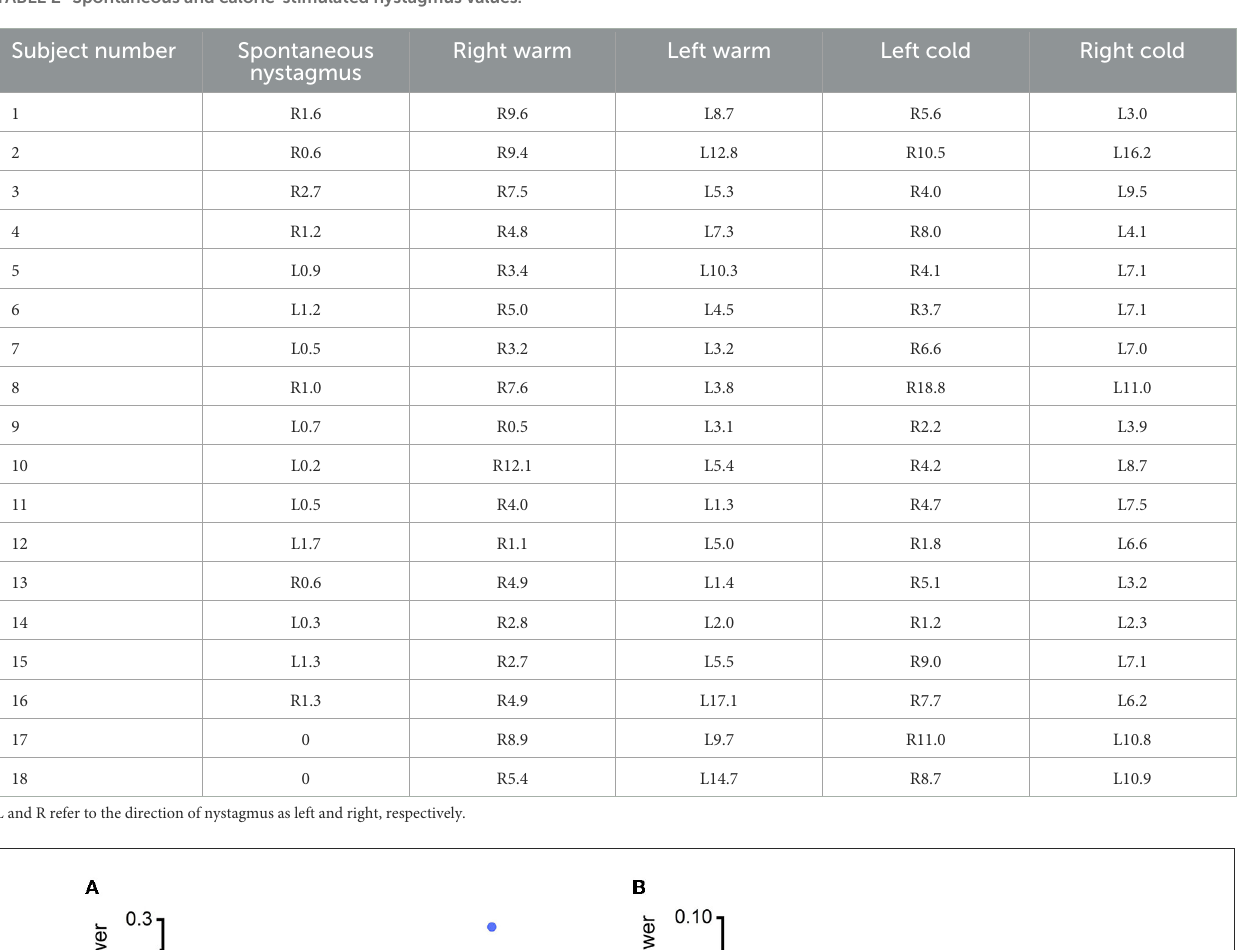
TABLE 2 Spontaneous and caloric-stimulated nystagmus values.